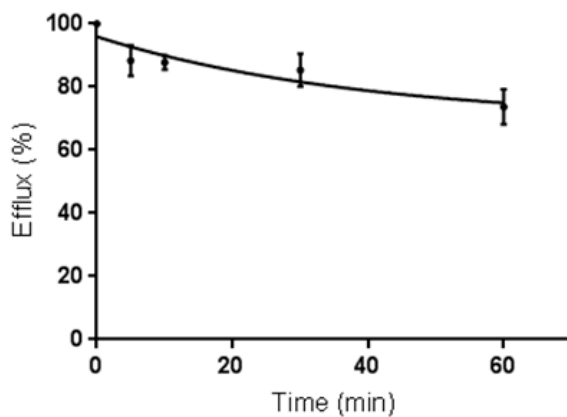
Figure 7. Externalization of 68 Ga-DOTA-C21 in HT-29 colorectal cancer cell line at different time points ( n = 3, mean ± SD).